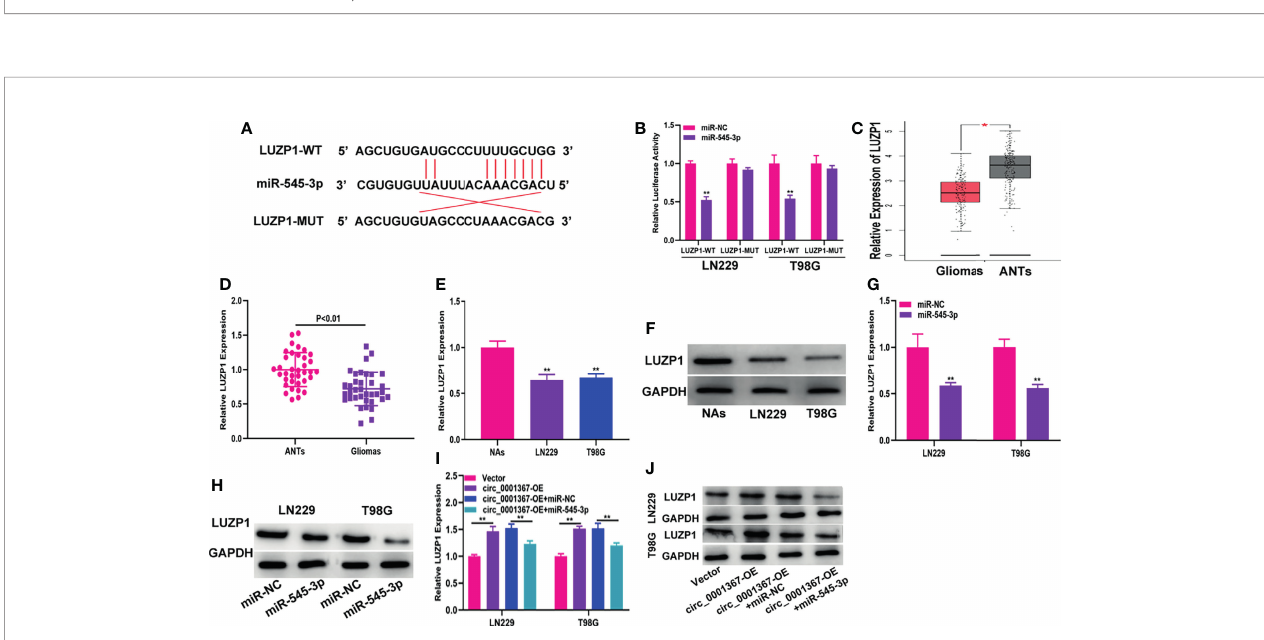
FIGURE 5 | LUZP1 is the direct target of miR-545-3p. (A) The binding sites of miR-545-3p and LUZP1 predicted by starBase. (B) The relative luciferase activity in T98G and LN229 cells was detected by dual-luciferase reporter assay. (C) The expression of LUZP1 in the public database (GEPIA). (D) The expression of LUZP1 in clinical samples detected by qRT-PCR. (E, F) The expression of LUZP1 in glioma cell lines detected by qRT-PCR and western blot. (G, H) LUZP1 expression in T98G and LN229 which transfected with miR-NC or miR-545-3p detected by qRT-PCR and western blot. (I, J) LUZP1 expression in T98G and LN229 cells transfected with vector, circ_0001367, circ_0001367+miR-NC or circ_0001367+miR-545-3p was detected by qRT-PCR and western blot. *P < 0.05, **P <